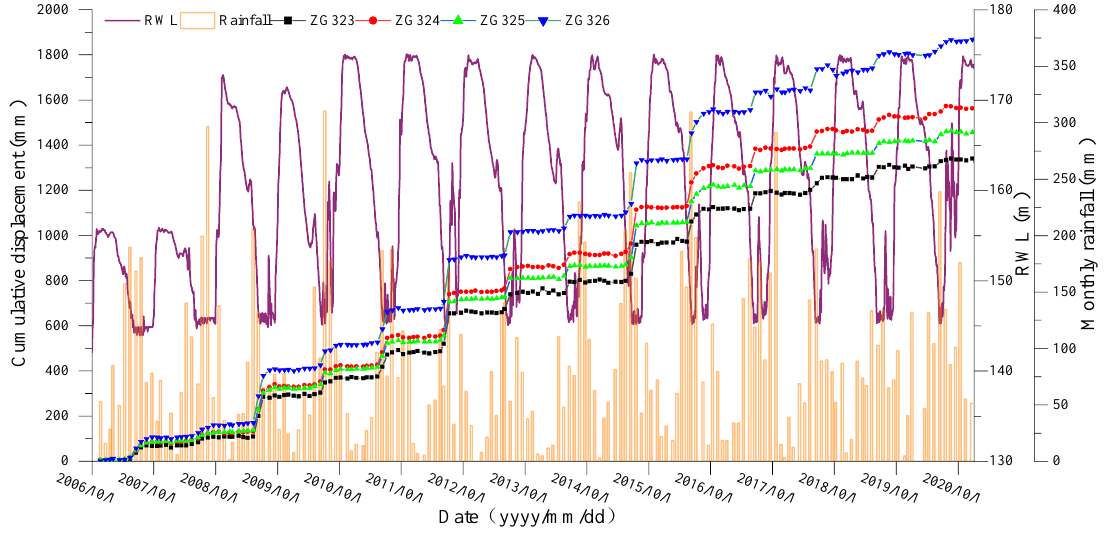
Figure 7. Time series of monitoring accumulative displacement, reservoir water level, and monthly rainfall.